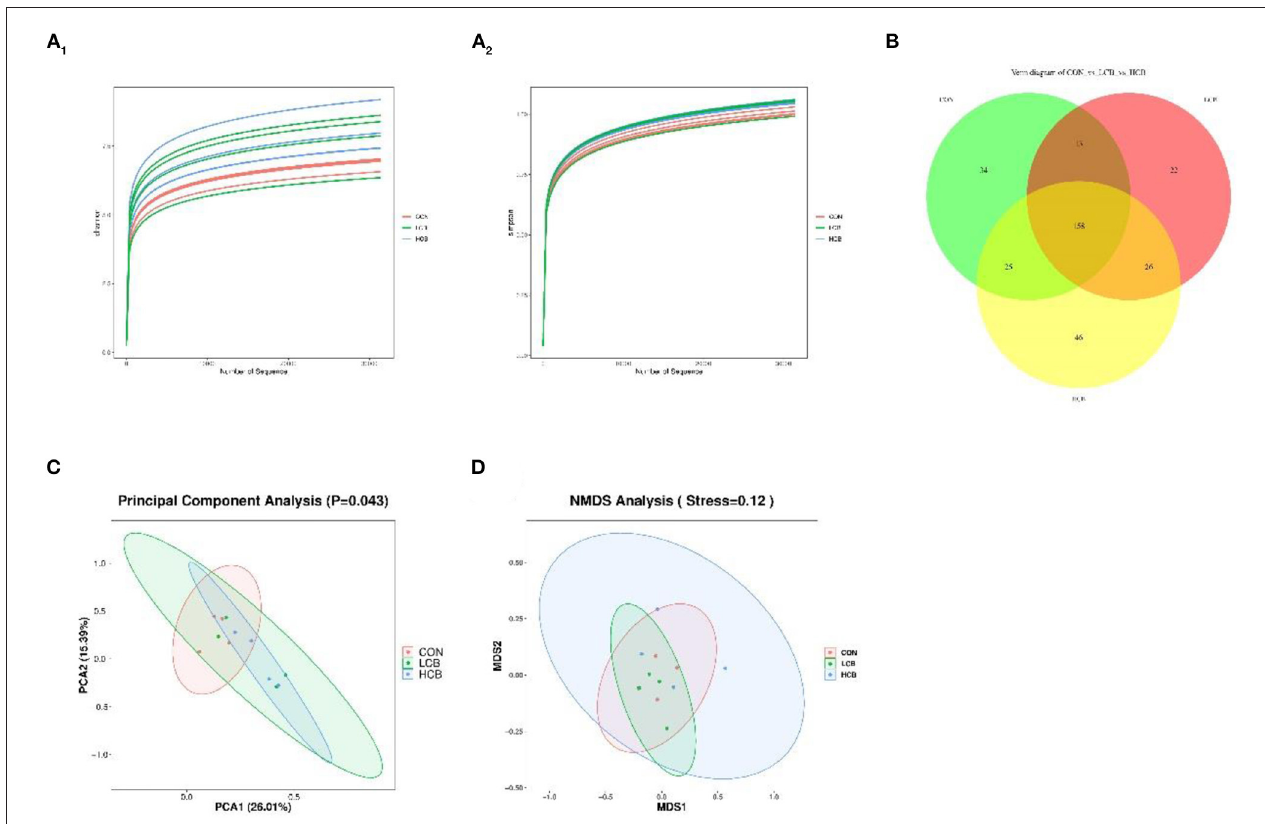
FIGURE 1 | The α - and β -diversity of rumen bacterial communities in fattening goats fed C. butyricum . Shannon (A 1 ) and Simpson (A 2 ) curves of rumen microbiome of fattening goats are shown. Unique and shared rumen feature among CON, LCB, and HCB groups (B) shown on Venn diagrams. Rumen microbial structure among the three groups was estimated by the Principal Component Analysis (C) and Nonmetric Multidimensional Scaling Analysis (D)